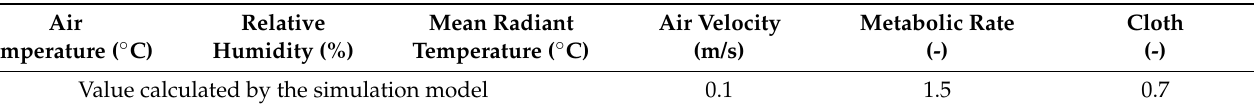
Table 6. Input values to calculate the